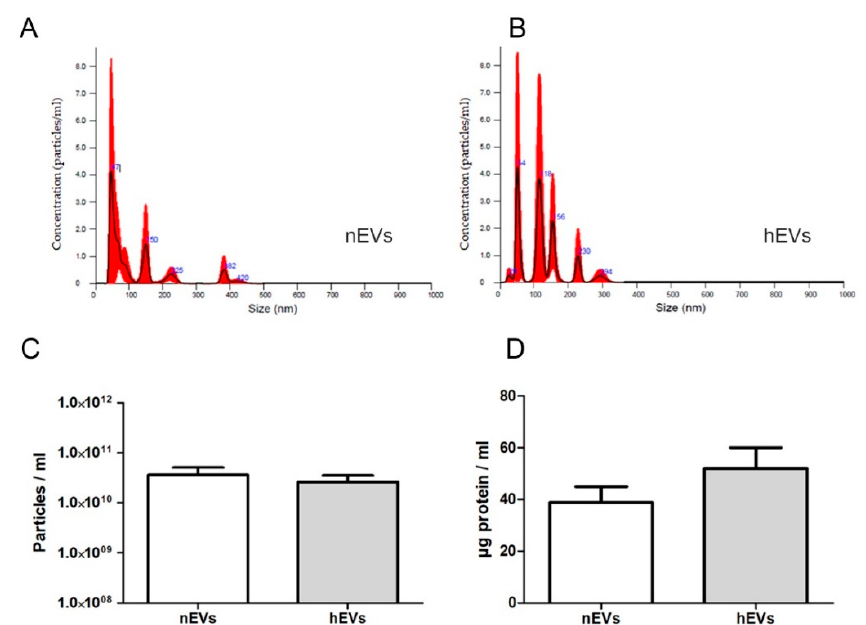
Figure 2. Characterization of isolated nanoparticle tracking analyses (EVs) from ASCs in normoxia and hypoxia. ( A , B ) Representative nanoparticle tracking analyses (NTA) of EVs isolated from ASCs after culture in a normoxic ( A ) or hypoxic ( B ) environment for 48 h. ( C ) Calculated absolute average number of isolated EVs measured by NTA using a NanoSight NS500 ( n = 13, ASCs cultured under normoxic conditions (nEVs); n = 9 ASCs cultured under hypoxic conditions (hEVs)). No significant differences were detected. ( D ) Calculated average protein content of isolated EVs ( µ g total protein normalized to mL conditioned medium used for EV isolation, n = 17 (nEVs), n = 10 (hEVs)). No significant differences were detected.